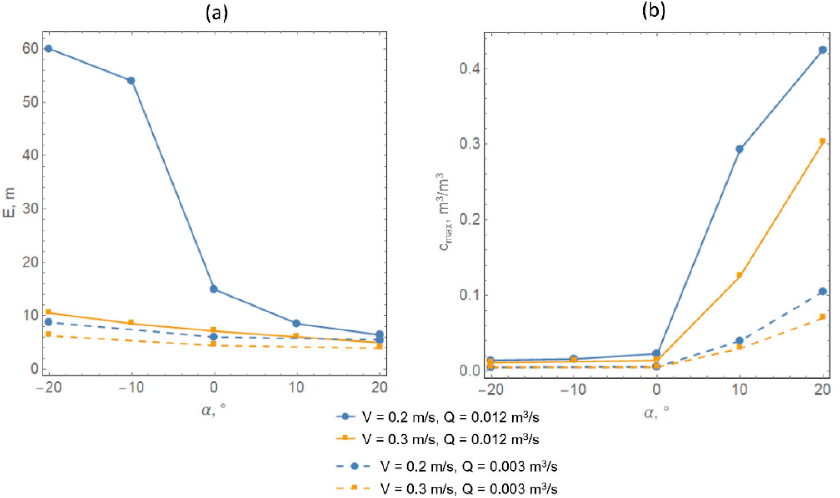
Figure 9. Dependence of ( a ) the length E and ( b ) the maximum methane concentration on the angle of inclination ( α ) of a dead ‐ end drift.